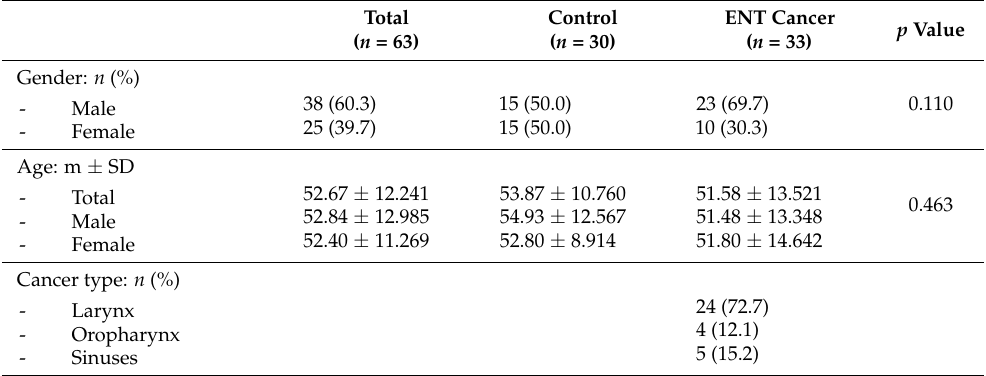
Table 1. Demographic characteristics of the study population (mean ± SD = standard